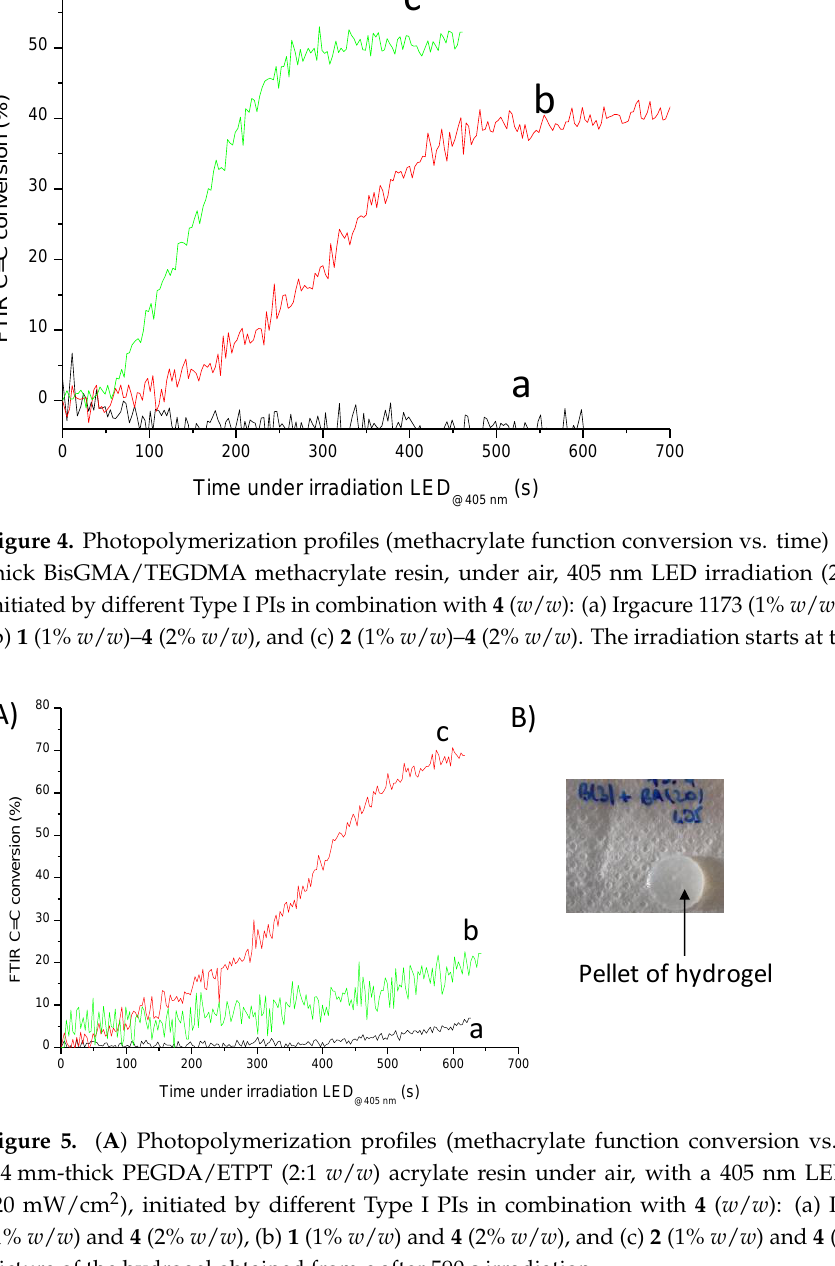
Figure 5. A ) Photopolymerization profiles (methacrylate function conversion vs. time) for a 1.4 mm- thick PEGDA/ETPT (2:1 w / w ) acrylate resin under air, with a 405 nm LED irradiation (20 mW/cm²), initiated by different Type I PIs in combination with 4 ( w / w ): (a) Irgacure 2959 (1% w / w ) and 4 (2% w / w ), (b) 1 (1% w / w ) and 4 (2% w / w ), and (c) 2 (1% w / w ) and 4 (2% w / w ). B ) Picture of the hydrogel obtained from c after 590 s irradiation.